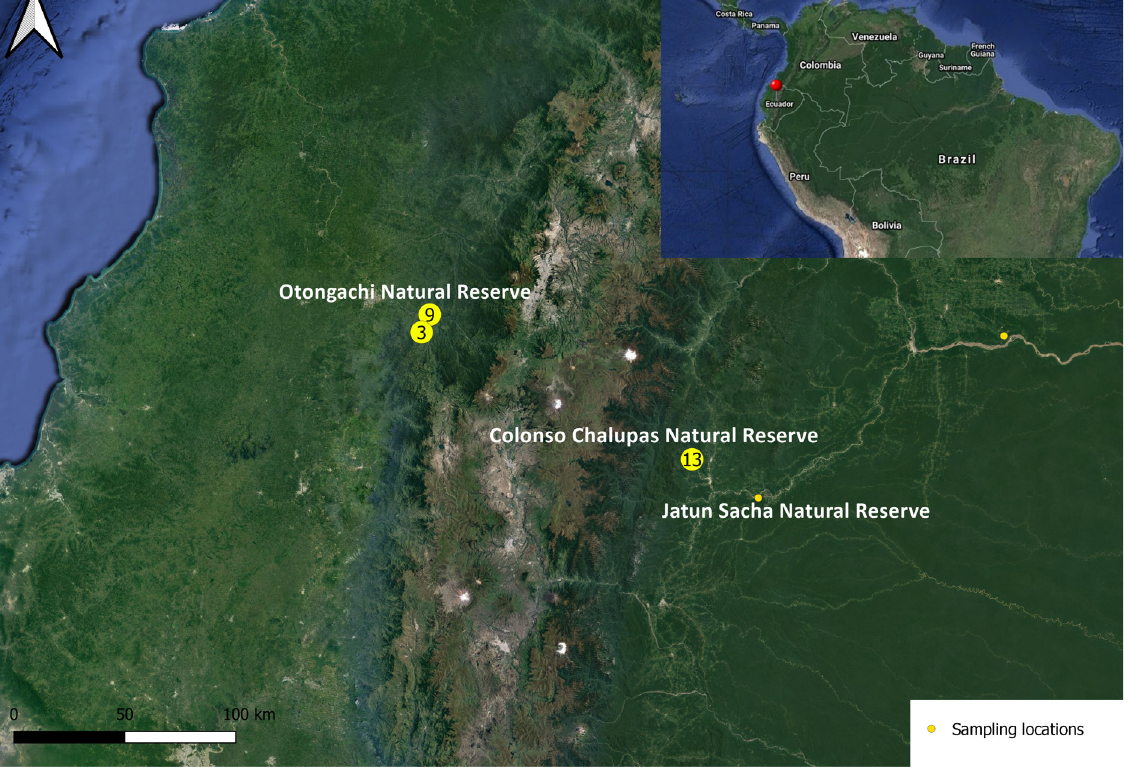
Fig. 1. Map indicating all sampling locations in Ecuador where specimens were collected. The numbers indicate overlapping